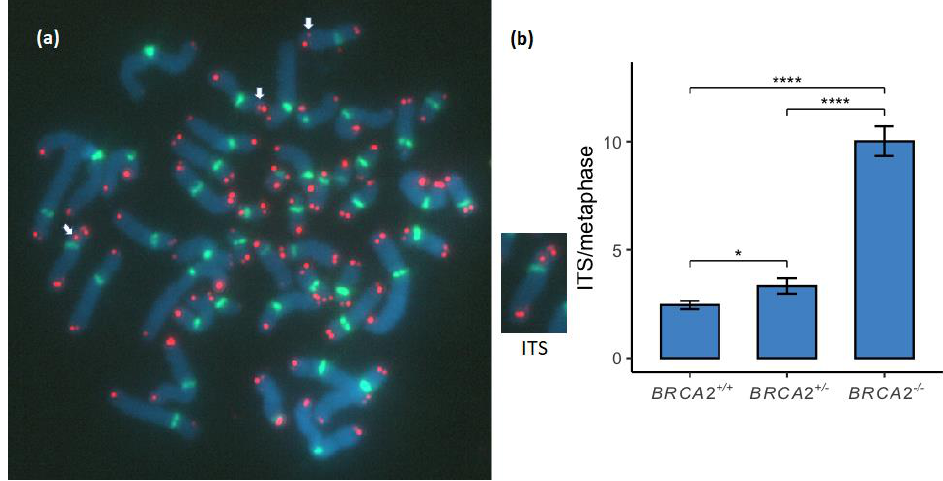
Figure 3. Interstitial telomere sequences (ITS) were compared between the BRCA2 genotypes. ( a ) ITS were measured as signals within a chromosome arm (white arrows). ( b ) ITS were found to be significantly increased between the genotypes of BRCA2 +/+ , BRCA2 +/ − and BRCA2 − / − in a stepwise manner ( p < 0.05 and p < 0.0001, respectively). * corresponds to p < 0.05 and **** corresponds to p < 0.0001. Metaphase chromosomes were analyzed with FISH by Cy3-conjugated telomere probe and FITC-conjugated centromere probe and counterstained with DAPI. The metaphase shown is from the EB6085 BRCA2 +/ − lymphoid cell line.